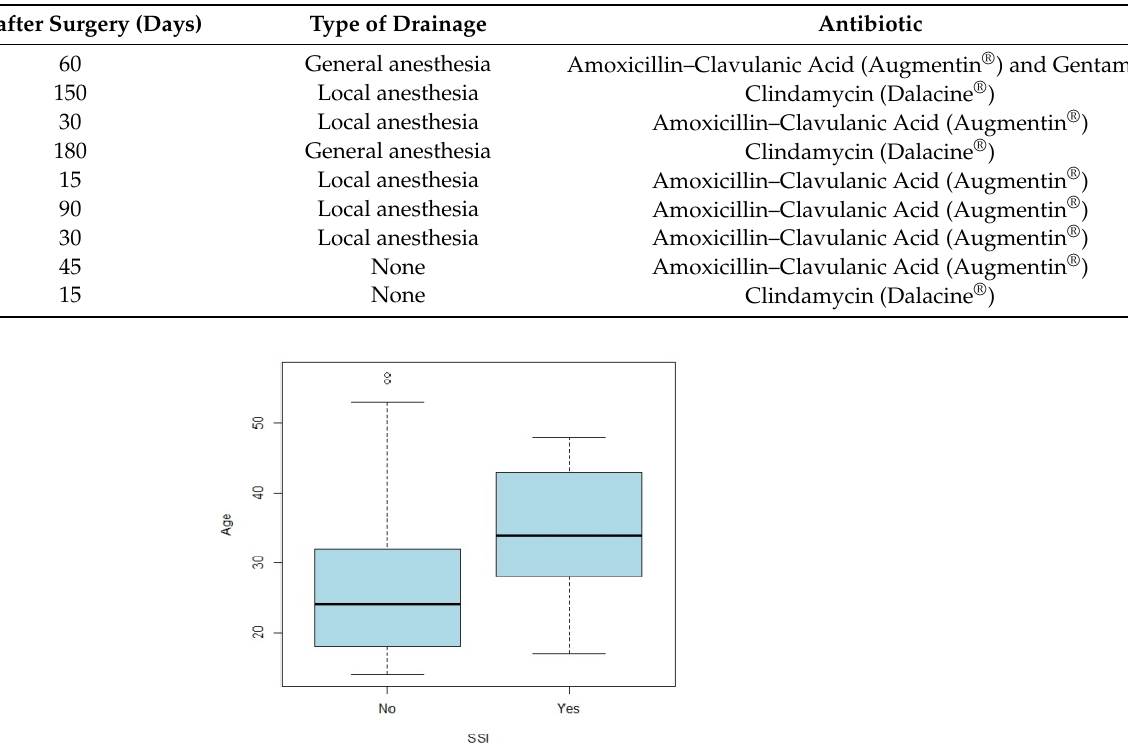
Figure 1. Duration of postoperative antibiotic therapy. Table 2. Details of Surgical Site Infection.